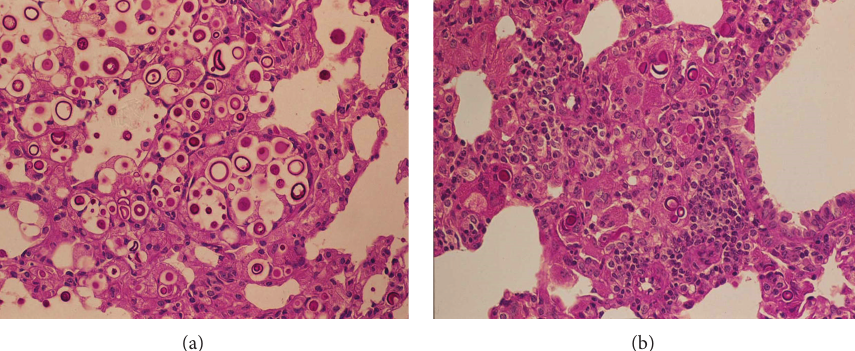
Figure 4: (a) Numerous and irregular-sized yeasts were diffusely observed in the pulmonary sections of cryptococcosis in homozygous (nu/nu) nude mice, but no multinucleated giant cell (MGC) was observed (periodic acid Schiff reaction, original magnification × 200). (b) MGCs with a well-developed and dense eosinophilic cytoplasm containing the yeasts were observed in the pulmonary sections of cryptococcosis in heterozygous ( nu /−) nude mice (periodic acid Schiff reaction, original magnification × 200).